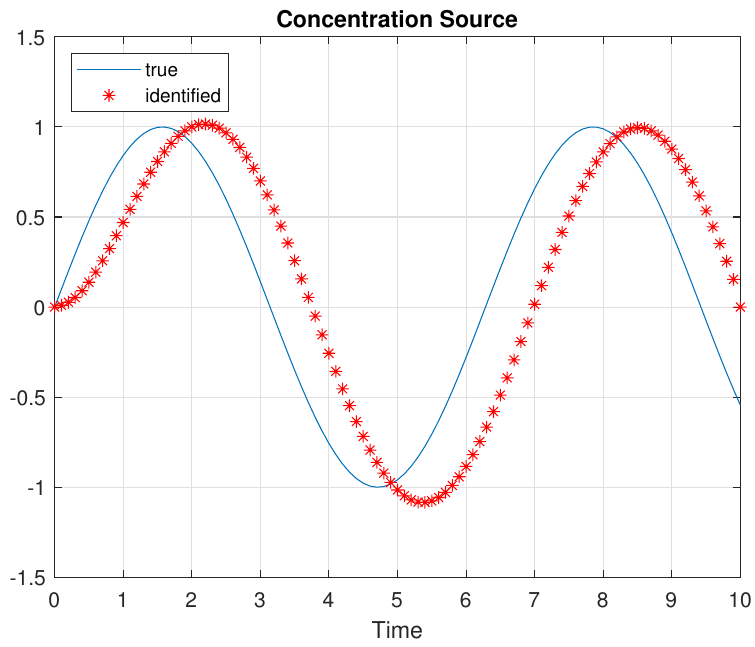
Figure 3. True and recovered values of the concentration source